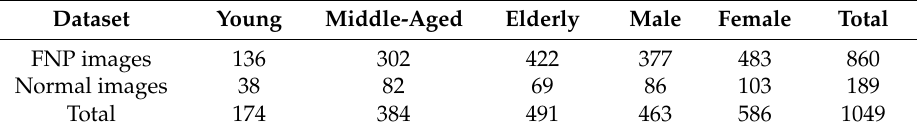
(Table 1). Our dataset covers patients of all ages and genders, while patient data are relatively evenly distributed. Table 1. Dataset Distribution. Table 1. Dataset Distribution. Table 1. Dataset Distribution.